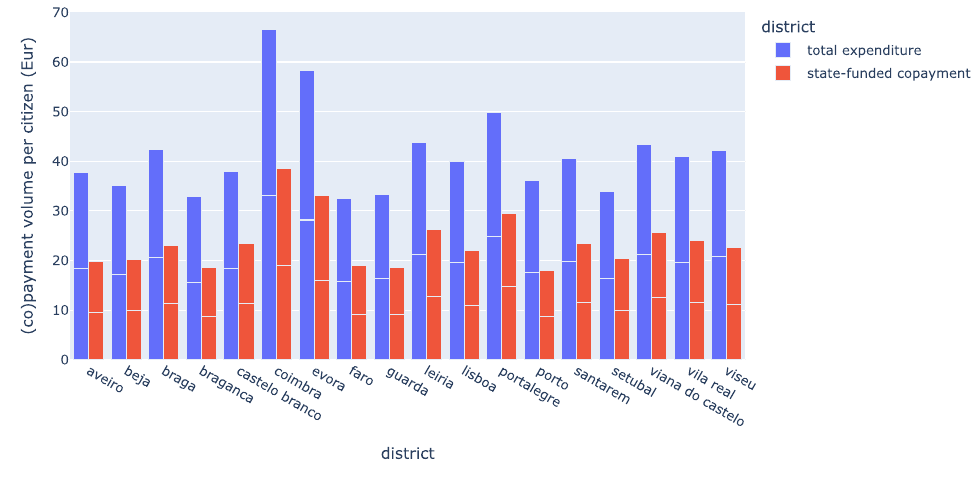
Figure 4. Annual expenditure per district, normalized by citizen,